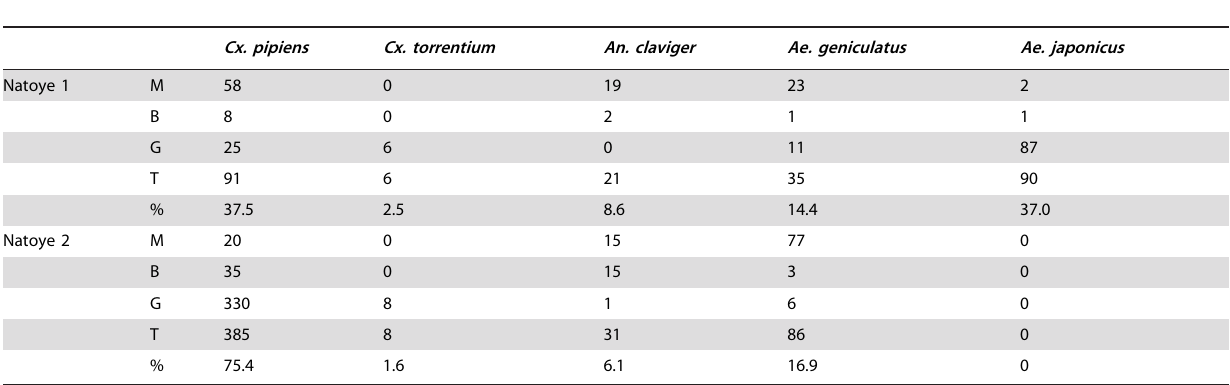
Table 2. Total numbers and percentages of adult mosquitoes of the 5 species found per trap kind during the 13 visits at Natoye 1 and Natoye